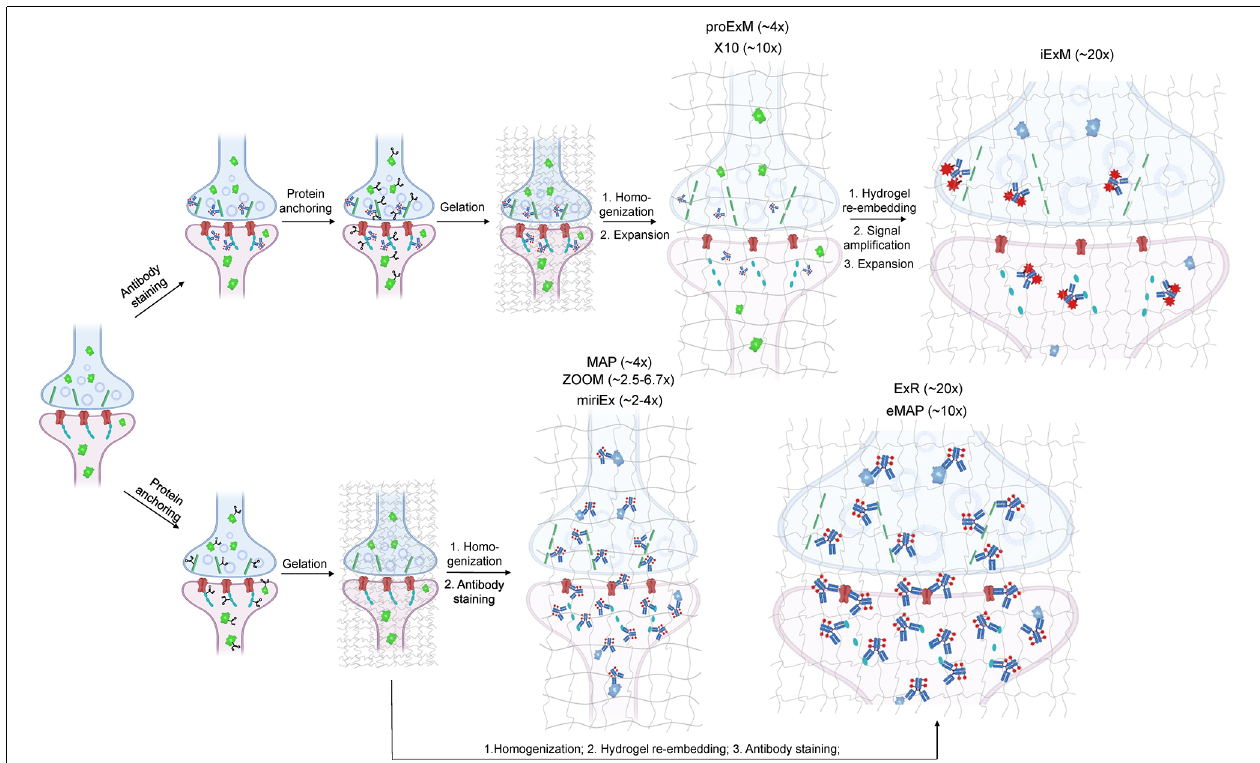
FIGURE 1 | Schematic representations of the ExM workflows with protein retention. Created with